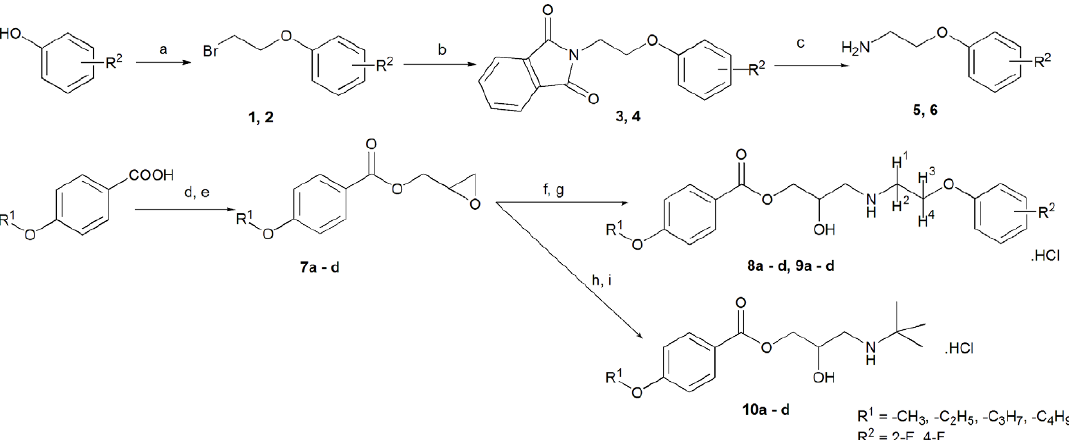
Scheme 1. Synthesis of the studied compounds. Reagents and conditions: a) 1,2-dibromoethane, NaOH; b) potassium phthalimide, DMF; c)